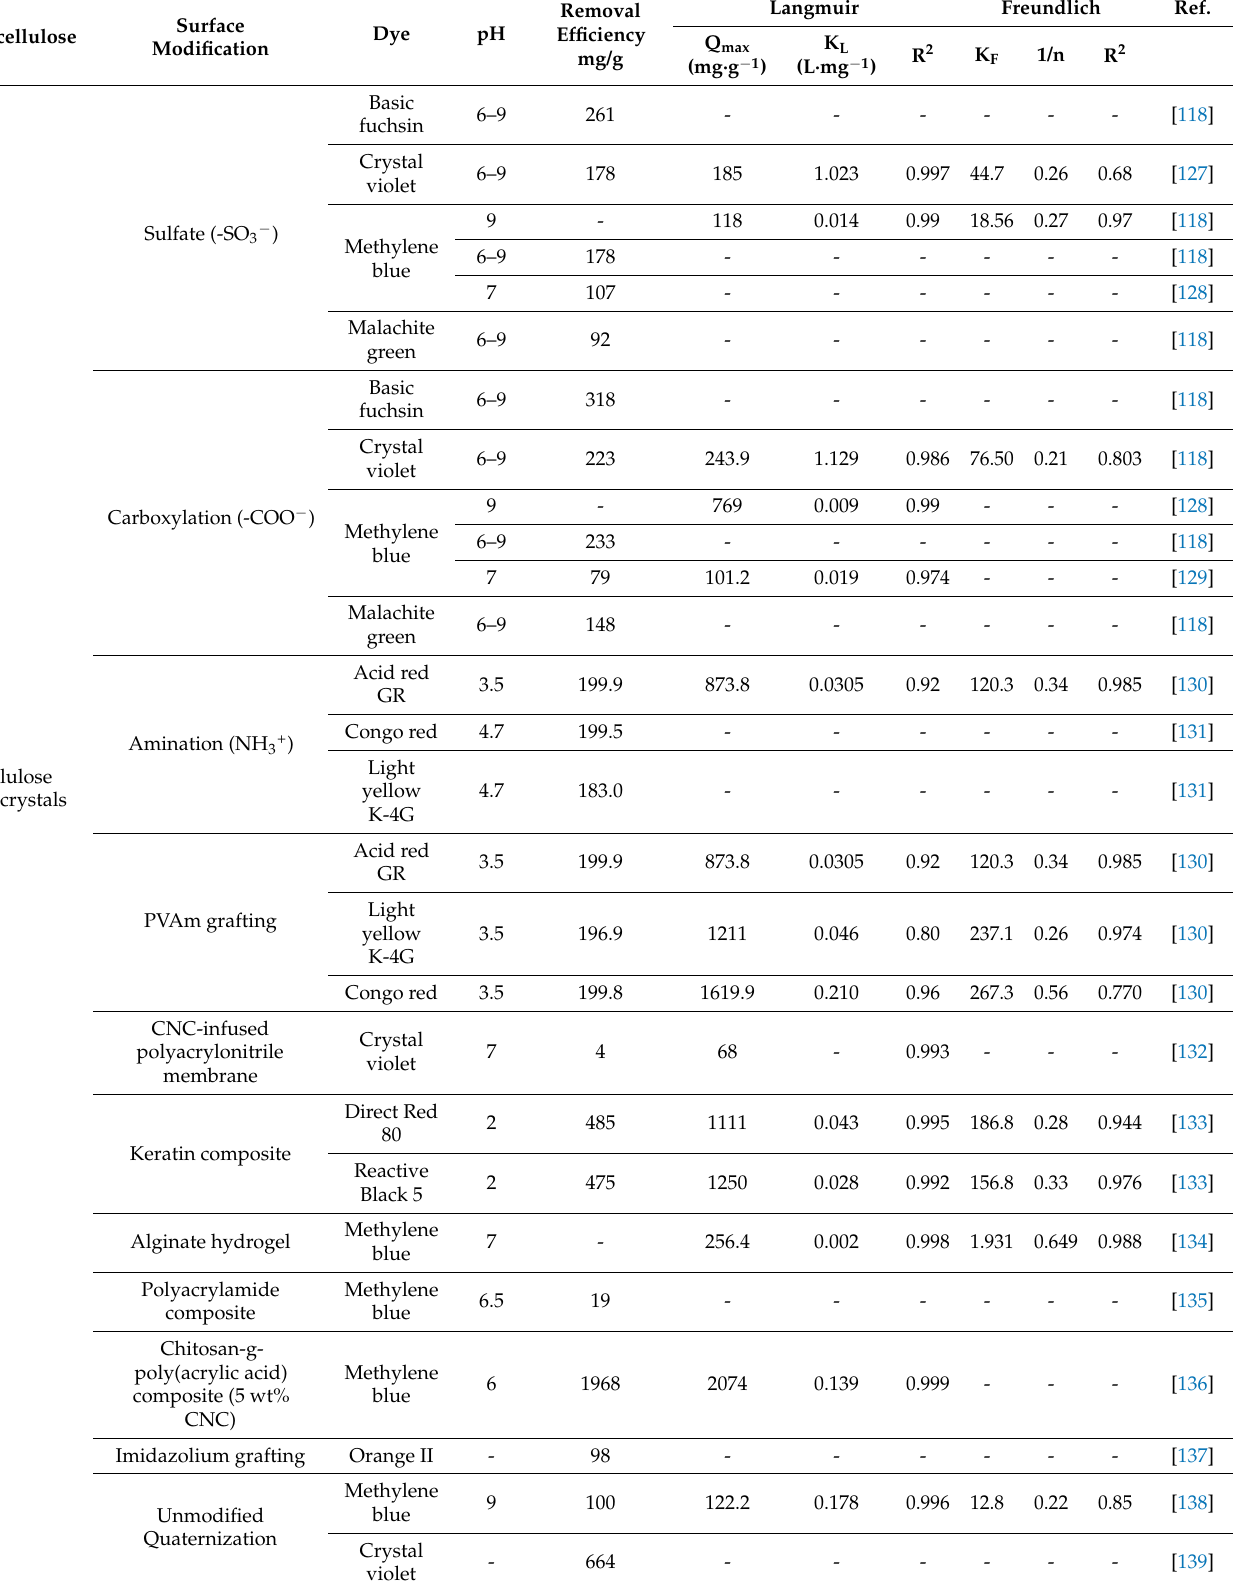
Table 4. Overview of the different nanocellulose types and their applications as adsorbents to remove organic pollutants.